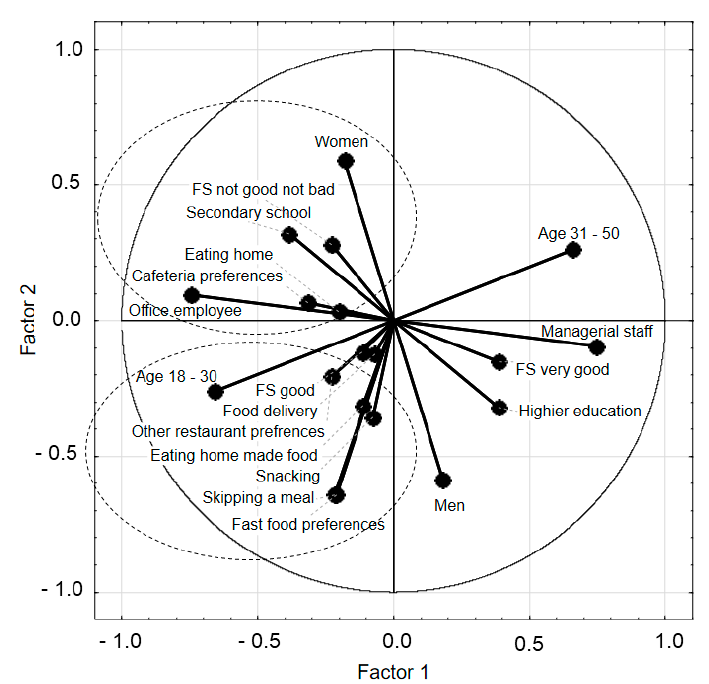
Figure 2. The analysis of consumer profile with the reasons for not using the staff canteens and the link of the indicated reasons and sociodemographic factors; FS—financial status.